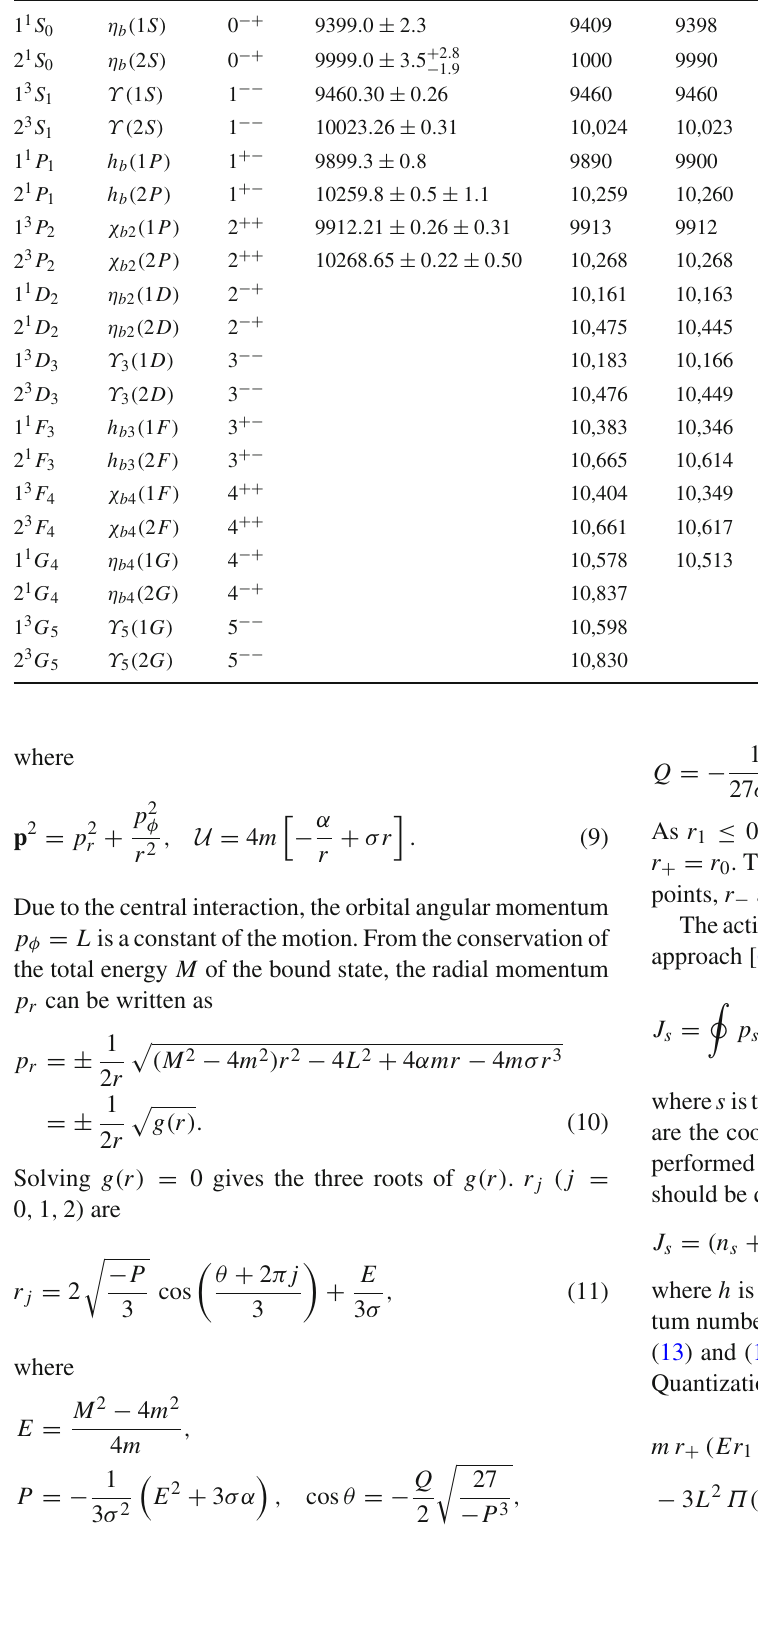
shown in comparison with the theoretical values of EFG13 [91], GM15 [92], SOEF16 [93] and